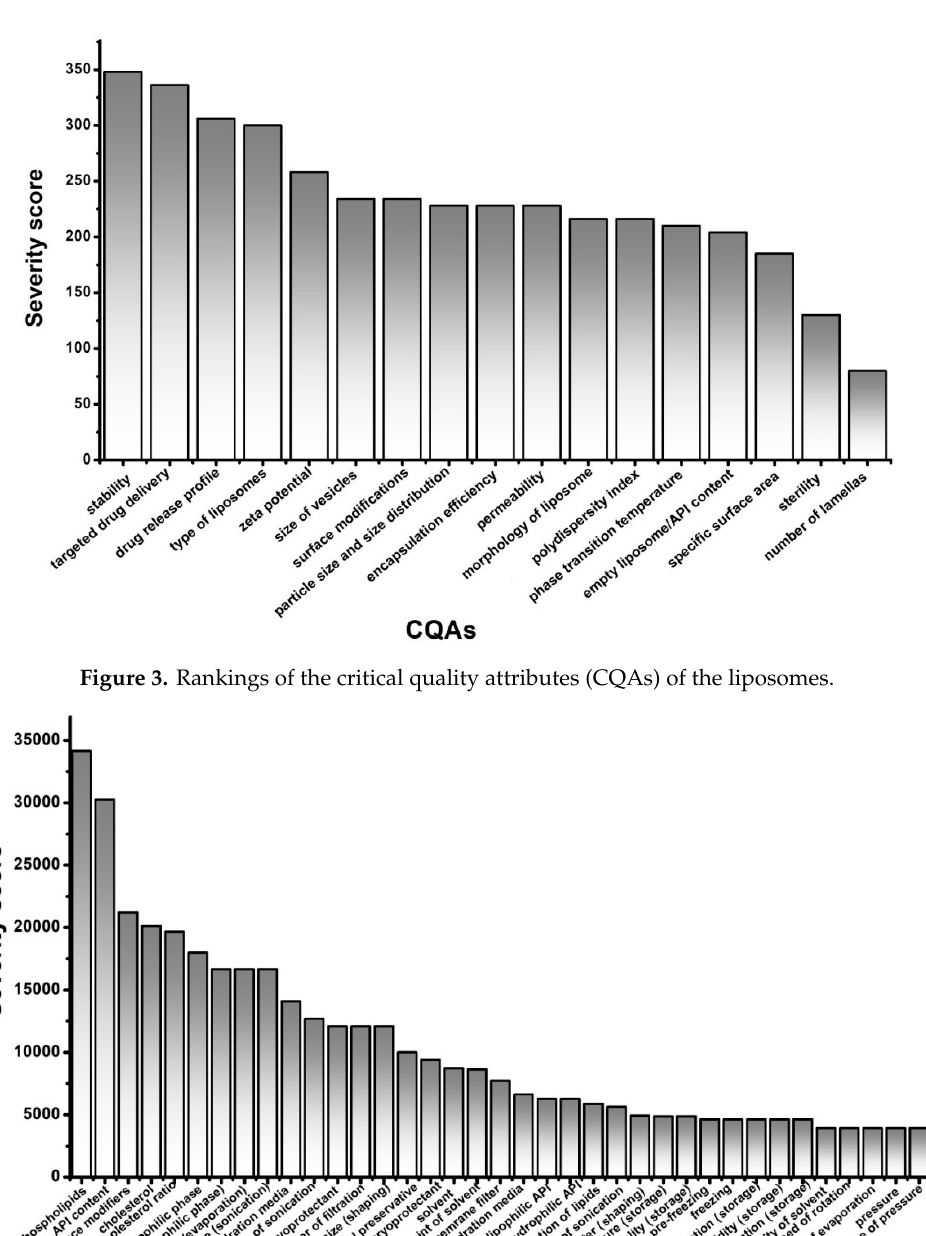
Figure 2. Collection of the properties of the liposome components (material attributes (MAs)) and the preparation method (process parameters (PPs)) that affect the result of the thin-film hydration liposome manufacturing technique.